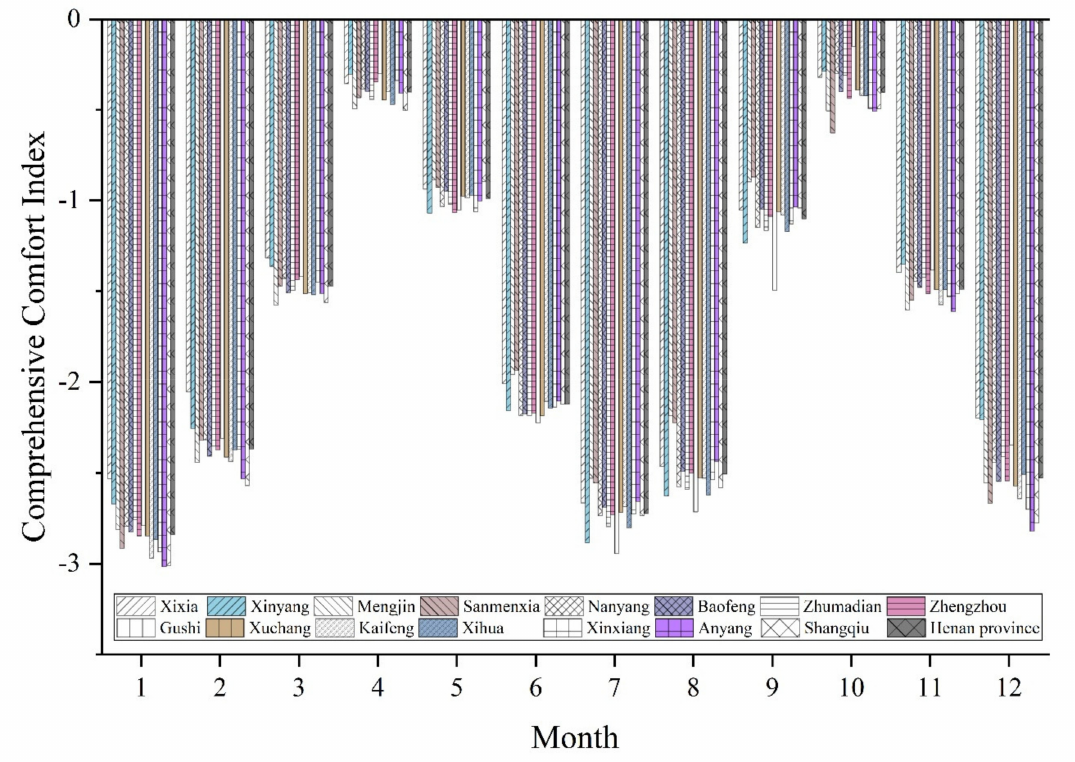
Figure 2. Monthly variation of the TCCI of each meteorological station and the whole province (average of all stations) in Henan